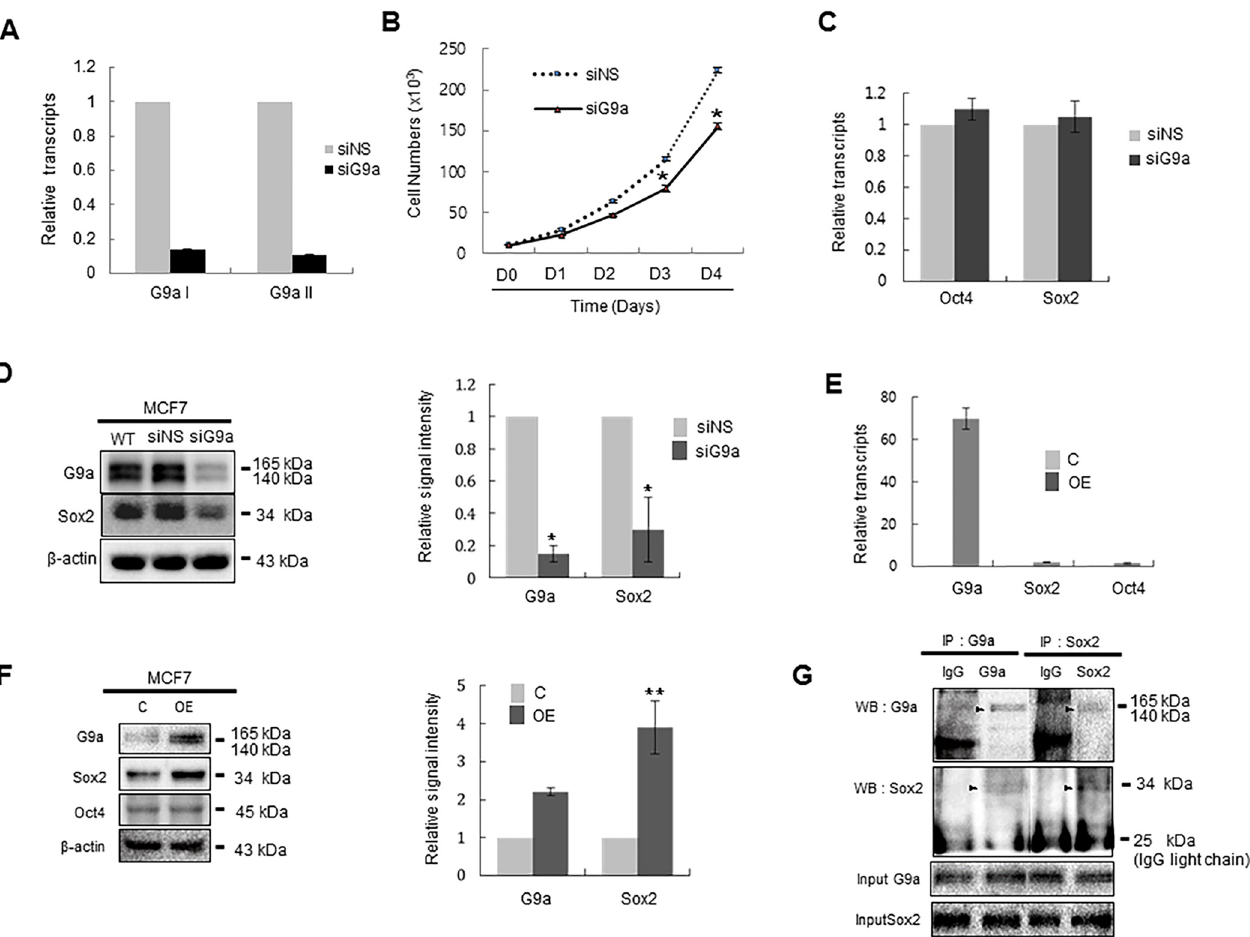
Fig 2. The expression level of G9a affects the amount of Sox2 protein in MCF7 cells. (A) MCF7 cells were transfected with siNS or siG9a for 24 h, and G9a transcript levels were analyzed by real-time PCR by priming two positions of G9a ORF (G9aI and G9aII). mRNA levels were normalized to those of GAPDH. G9aI and G9a2 primer sets were designed to amplify 1299~1531 bp and 2326~2637 bp of G9a ORF, respectively. (B) The effect of G9a on the proliferation of MCF7 cells. MCF7 cells (1 × 10 4 ) were transfected with siNS or siG9a and then counted at the indicated times post-transfection. (C) MCF-7 cells were transfected with siNS or siG9a for 24 h, and the effect of G9a knockdown on the transcription of Oct4 and Sox2 was quantitatively analyzed by real-time RT-PCR. (D) MCF-7 cells were transfected with siNS or siG9a for 24 h, and the effect of G9a knockdown on the amount of Oct4 and Sox2 protein was analyzed by immunoblot analysis. (E) MCF-7 cells were transfected with control or G9a expression plasmids for 24 h, and the effect of G9a overexpression on the transcription of Sox2 and Oct4 was quantitatively analyzed by real-time RT-PCR. (F) MCF-7 cells were transfected with control or G9a expression plasmids for 24 h, and the effect of G9a overexpression on the amount of Sox2 and Oct4 was quantitatively analyzed by immunoblot analysis. (G) Co-immunoprecipitation of endogenous Sox2 and G9a in MCF7 cells. Total protein extract of MCF7 cells was immunoprecipitated with Sox2 and then immunoblotted with G9a antibody. The reciprocal experiment was also performed in which total protein of MCF7 cells was immunoprecipitated with G9a and then immunoblotted with Sox2 antibody. The specific bands corresponding to the G9a and Sox2 was arrowed. Abbreviations: siNS, non-specific siRNA; siG9a, siRNA targeting G9a; C, control plasmid; OE, G9a-expressing plasmid; IP, immunoprecipitation; IB: immunoblotting. For quantitative analysis of the immunoblotting results, the mean density of the Sox2 or G9a bands was measured with Multi Gauge V3.0 software. The band density was then divided by the density of β -actin to obtain the normalized band density. * P < 0.05 and ** P < 0.01 compared with the control group. Data are expressed as the mean ± SDS and are representative of three independent